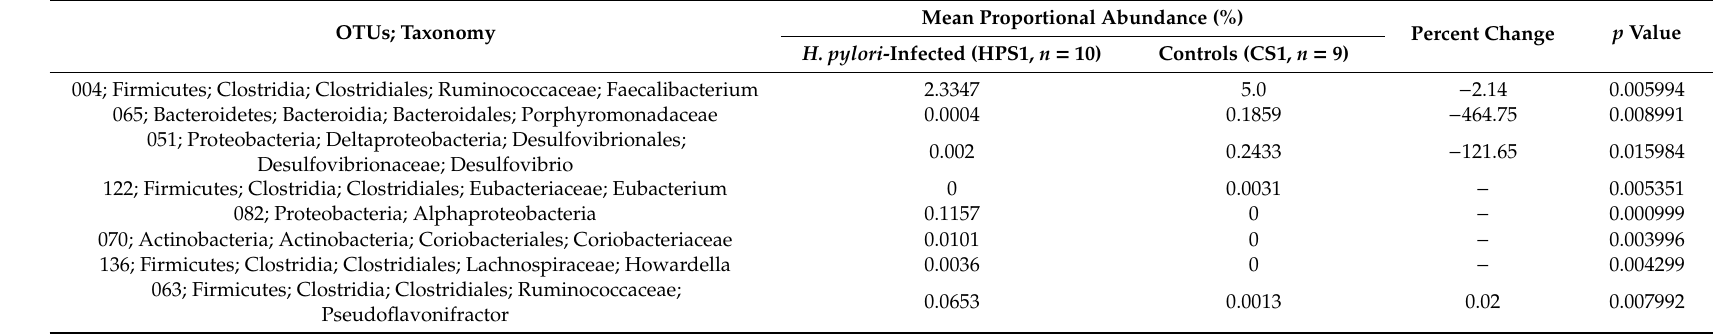
Table 1. The mean proportional abundance of eight genes with significant di ff erences in the feces between H. pylori -infected children and